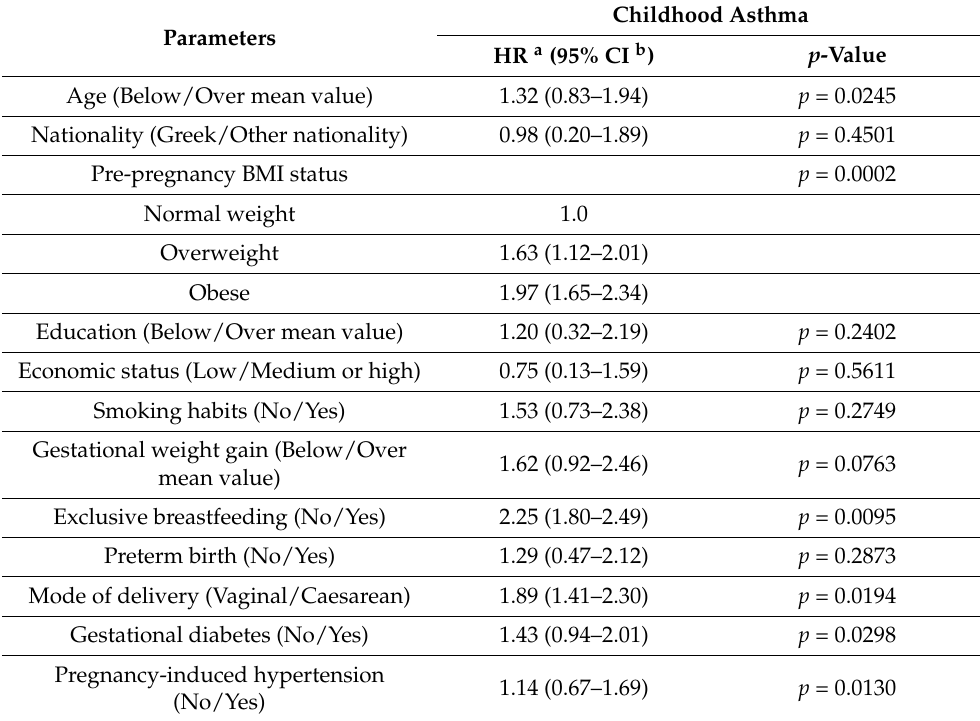
Table 2. Multivariate logistic regression analysis for childhood asthma adjusted for potential